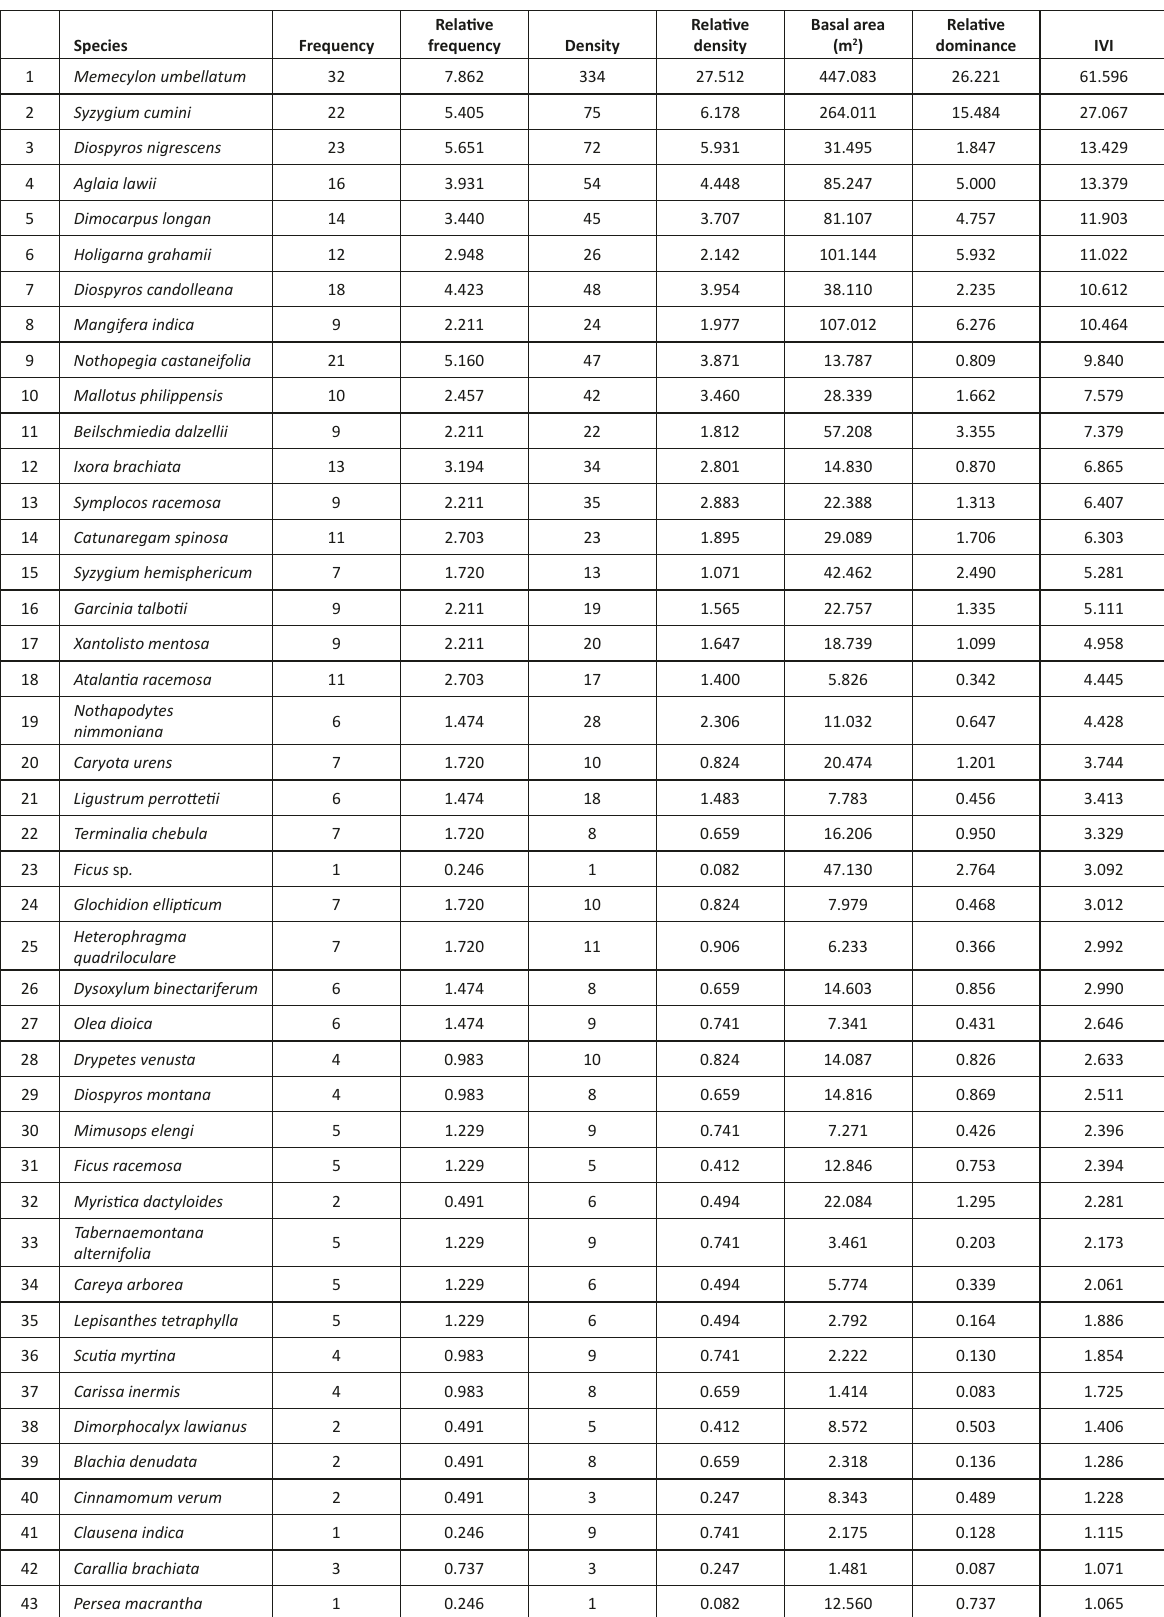
Table 3. Importance Value Index of the species from the study